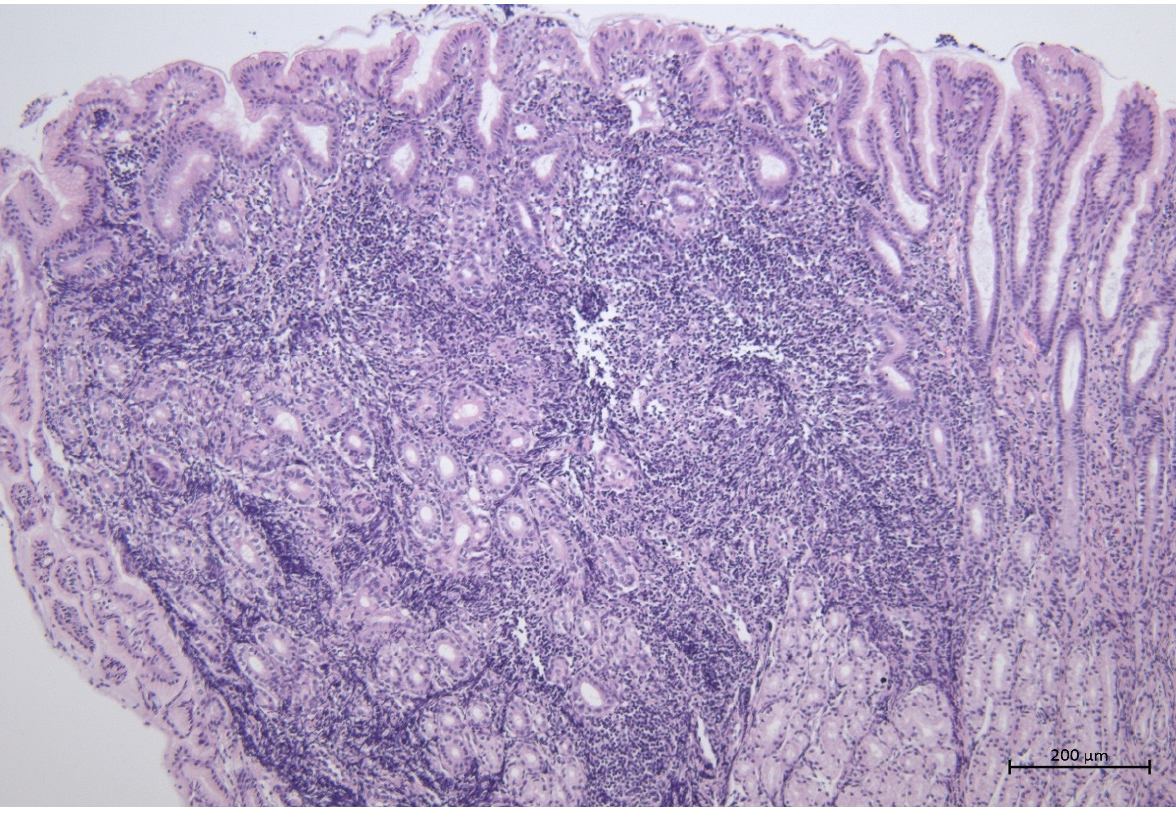
Figure 2. Marked lymphocytic duodenitis, magnification 100×.